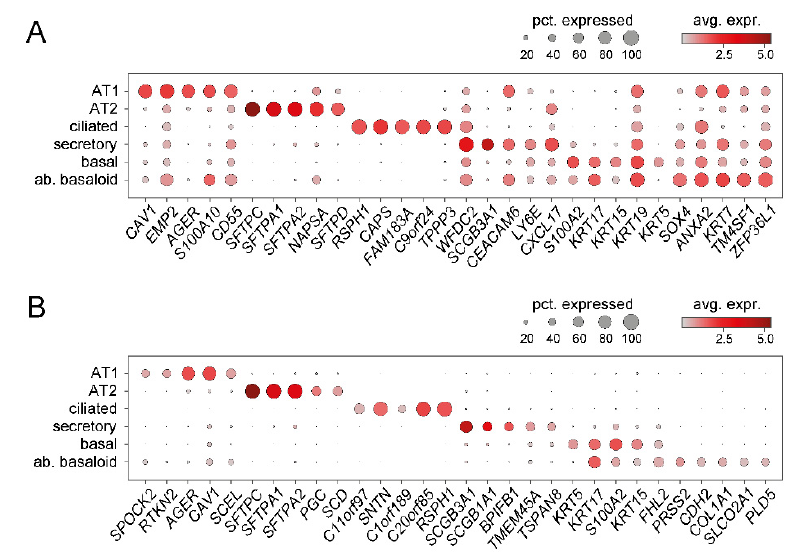
Figure 4. Cell type-specific markers for epithelial cell populations in ILD derived from scRNA-Seq data. Using the data set described in Figure 3, the top 5 specific markers for the described epithelial populations are plotted, ( A ) ranked by adjusted p -value or ( B ) ranked by log fold changes of relevant cell type vs. all other epithelial cell types. pct., percentage; avg. expr., average expression; ab.,